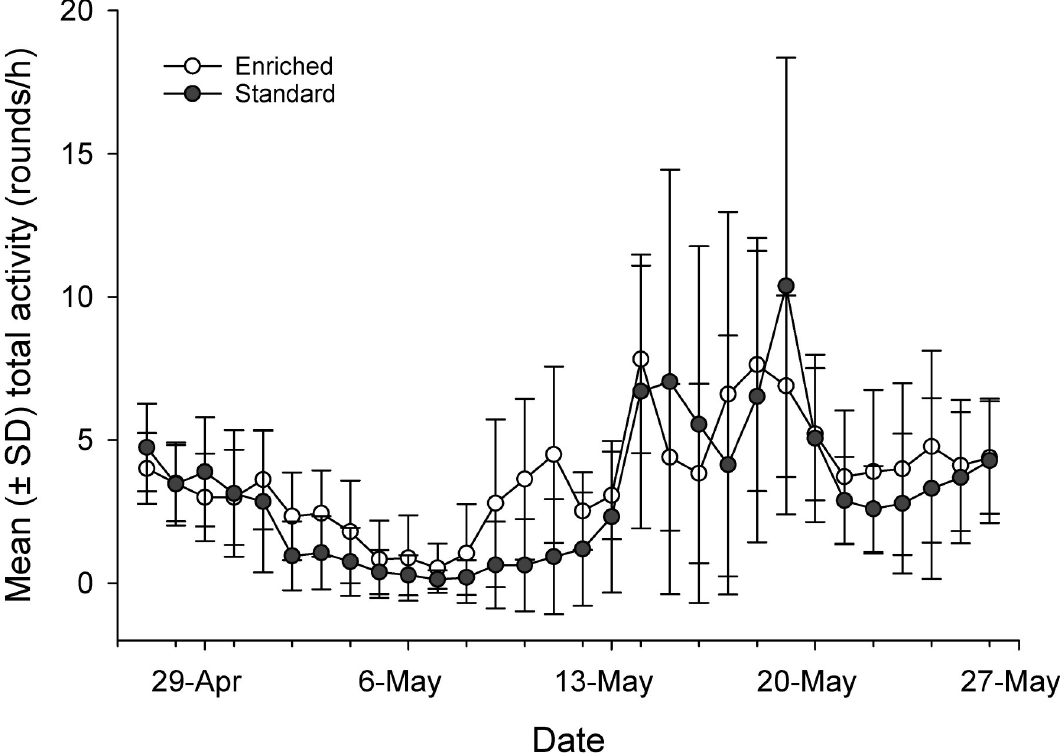
Fig 3. Mean ± SD of average daily activities in enriched- ( n = 495) and standard-reared fish ( n = 491) over the whole experiment as starting from 13:00 on 27 April 2019 and ending on 28 May at 13:00. Daily activity means in enriched- and standard-reared salmon during the smolt migration experiment.